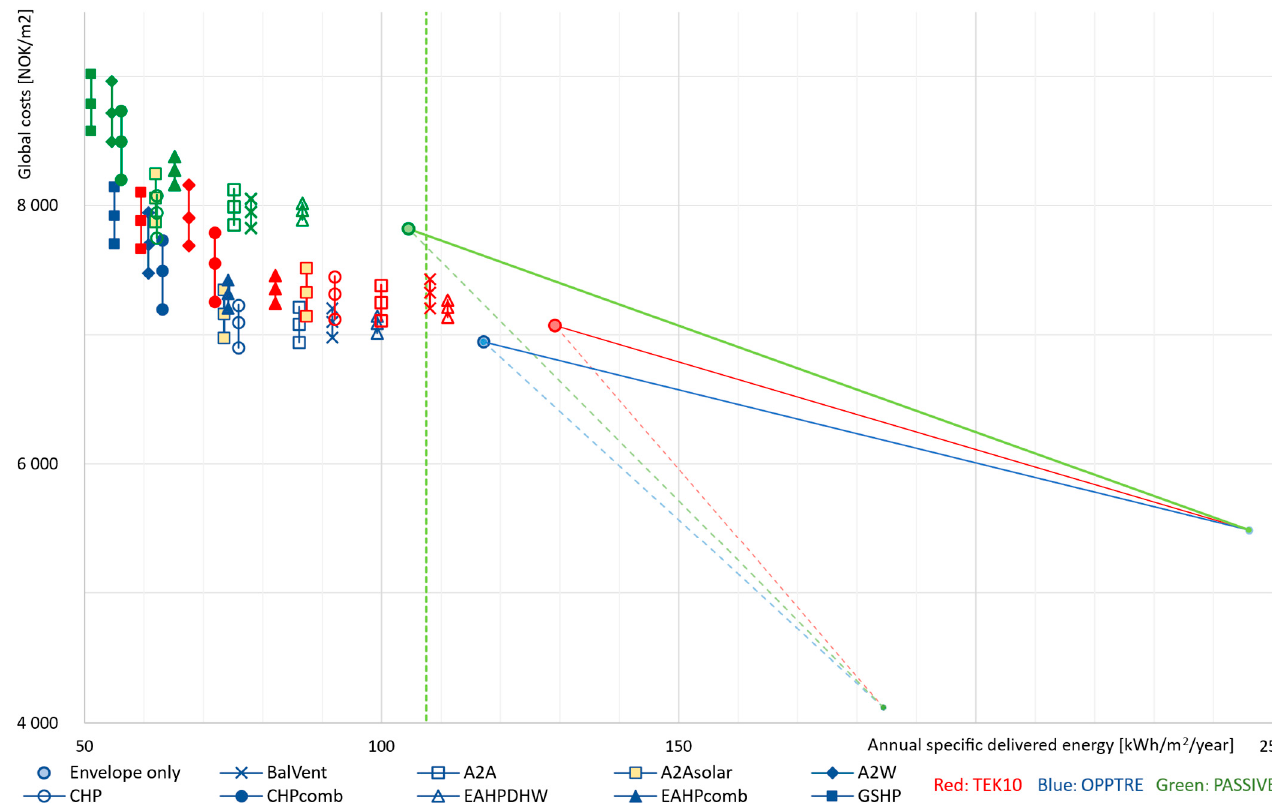
Figure A5. Specific global costs and delivered energy of the Kristiansand house. Baseline scenario without government support, and electricity price of 1.5 NOK/kWh. Initial situation before upgrading to the very right. Dotted lines suggest scenario with a prebound effect of 25% included.